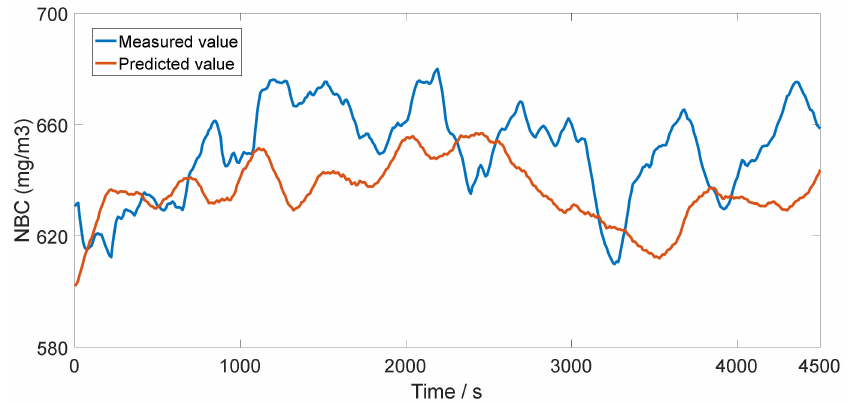
Figure 8. Trend of actual and predicted NO X value of 5000 t / d production